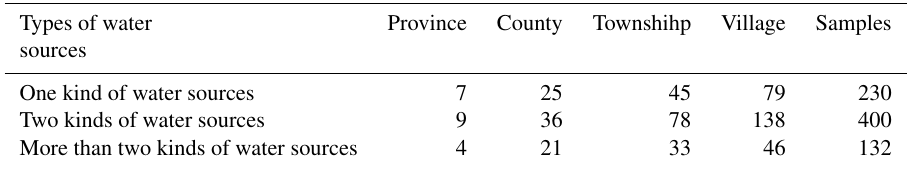
Table A2. Sample distribution based on types of water source. Types of